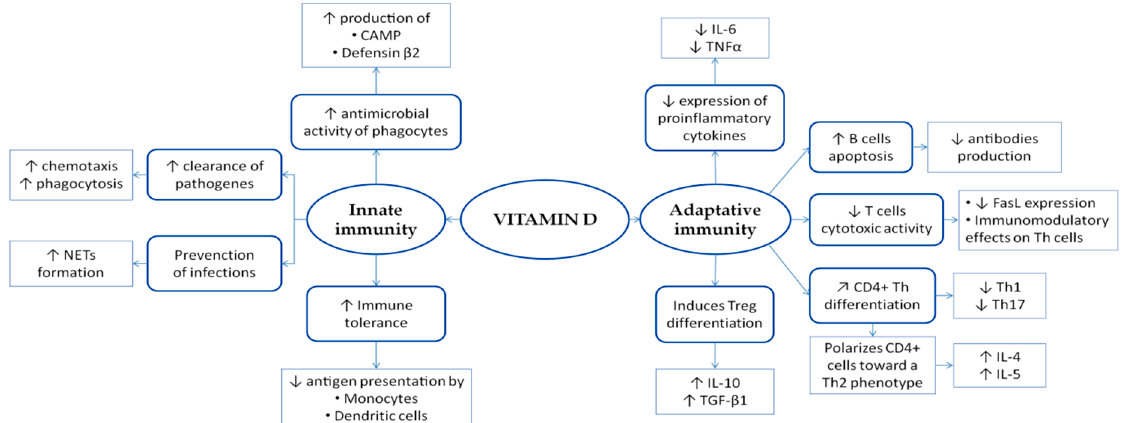
Figure 1. Scheme of vitamin D modulating role in immune response. As detailed in the text, vitamin D interferes with innate and adaptative immunity through different mechanisms. Arrows illustrate D interferes with innate and adaptative immunity through di ff erent mechanisms. Arrows illustrate increase ( ↑ ), decrease ( ↓ ) or regulation/modulation ( ↗ ) of specific actions, processes, cells, or increase ( ↑ ), decrease ( ↓ ) or regulation / modulation ( (cid:37) ) of specific actions, processes, cells, or molecules. molecules. Abbreviations: CAMP, cathelicidin antimicrobial peptide; FasL, Fas-ligand; IL, Abbreviations: CAMP, cathelicidin antimicrobial peptide; FasL, Fas-ligand; IL, Interleukin; NETs, Interleukin; NETs, neutrophil extracellular traps; TGF, transforming growth factor; Th, T helper; neutrophil extracellular traps; TGF, transforming growth factor; Th, T helper; TNF, Tumor Necrosis TNF, Tumor Necrosis Factor; Treg, T regulatory. Factor; Treg, T